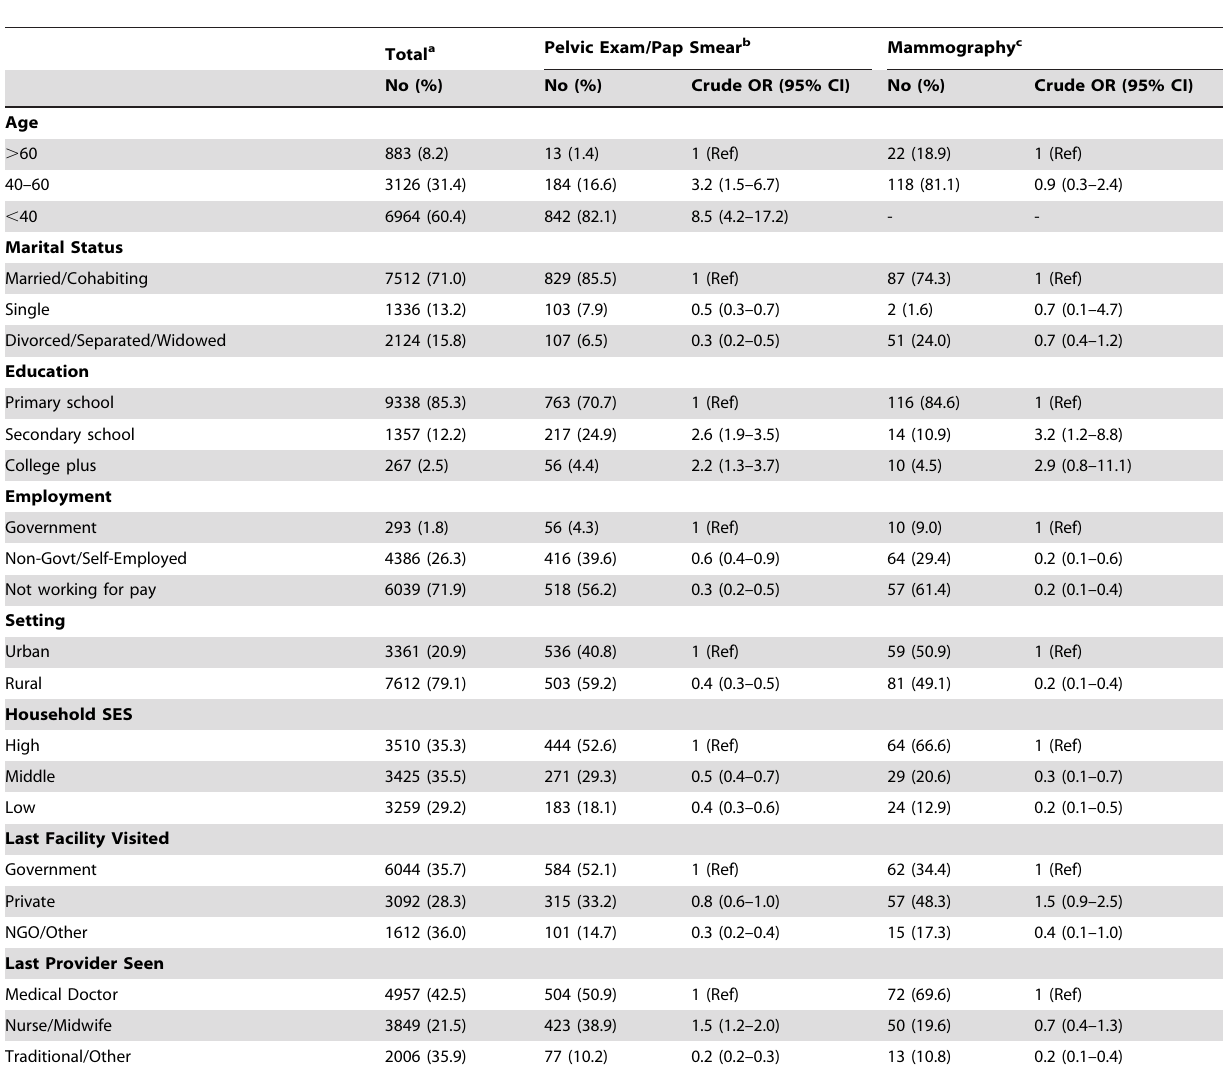
Table 1. Distribution of Study Characteristics, 2003 World Health